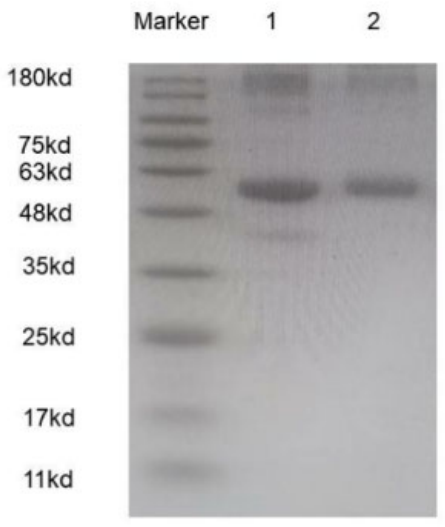
Fig. 6. SDS-PAGE identification of artificial antigen ZEN- BSA. 1 Marker; 2 BSA; 3 ZEN-BSA